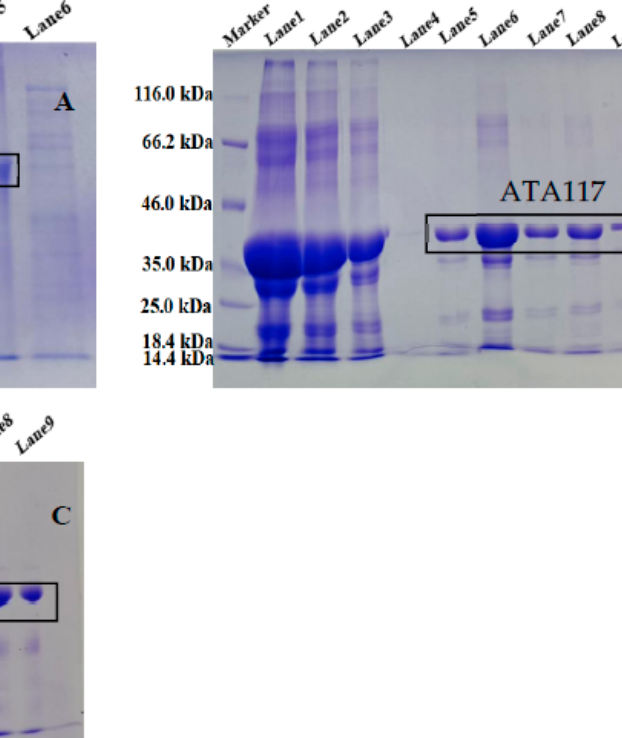
ATA117, pET28a-ATA117, pACYCDuet-ATA117 ( A ), the purification of ATA117 expressed by bacteria